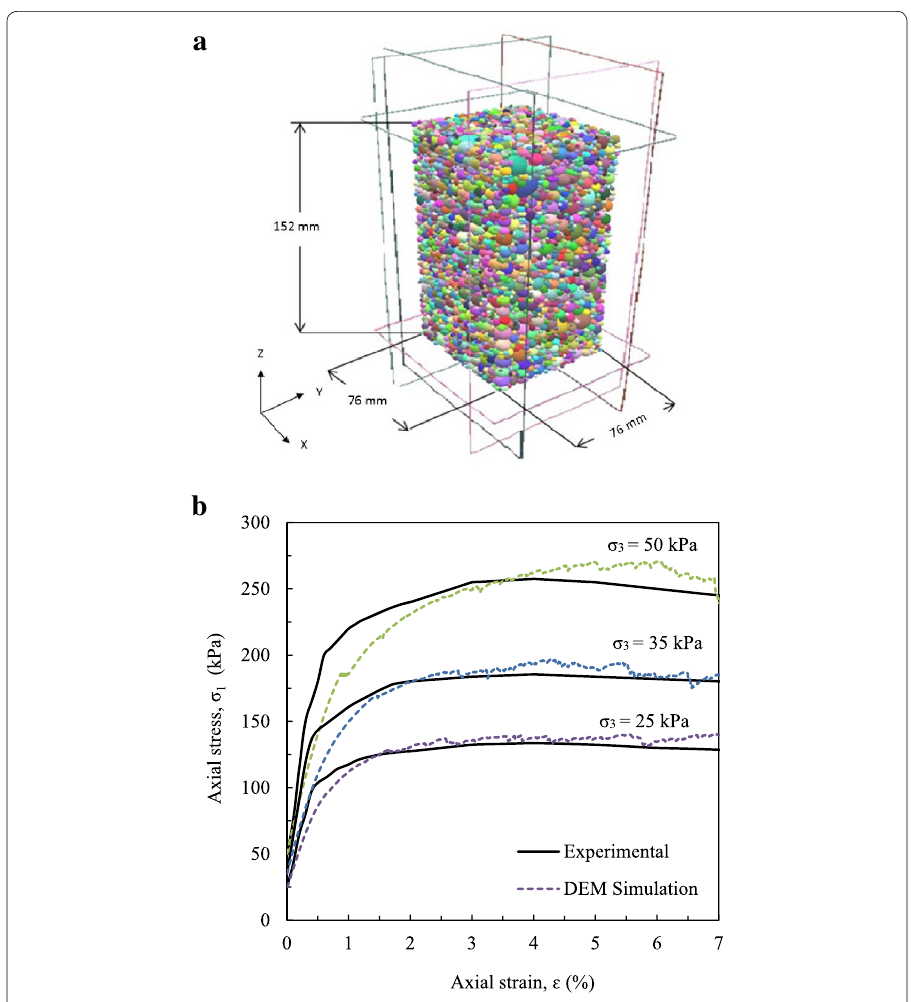
Fig. 4 Triaxial test used in calibration to find material input parameters: a tested sample; b results for differ- ent confining pressures